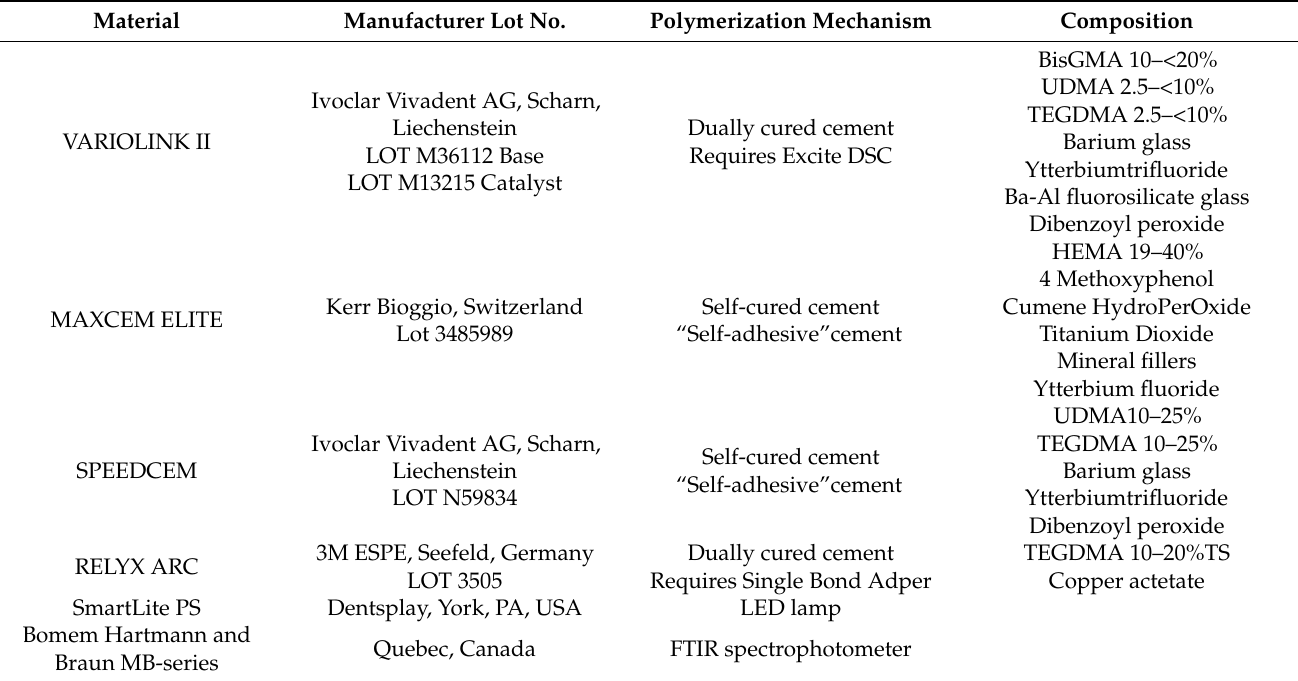
Table 1. Dental cement materials and instruments used in the